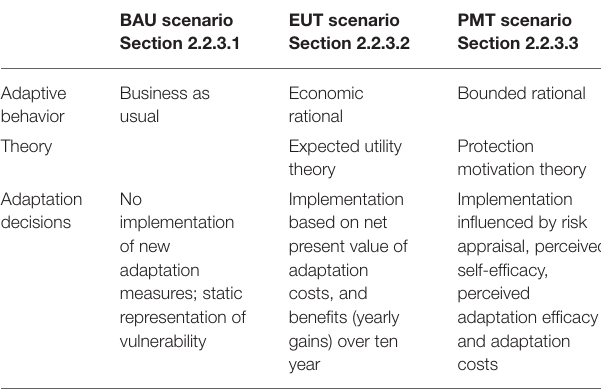
TABLE 1 | Scenario’s used in the ADOPT